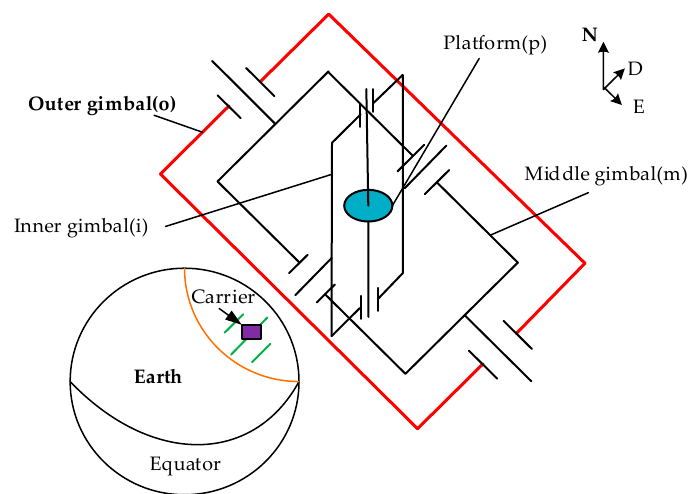
Figure 4. High-precision four-gimbal platform INS structure.